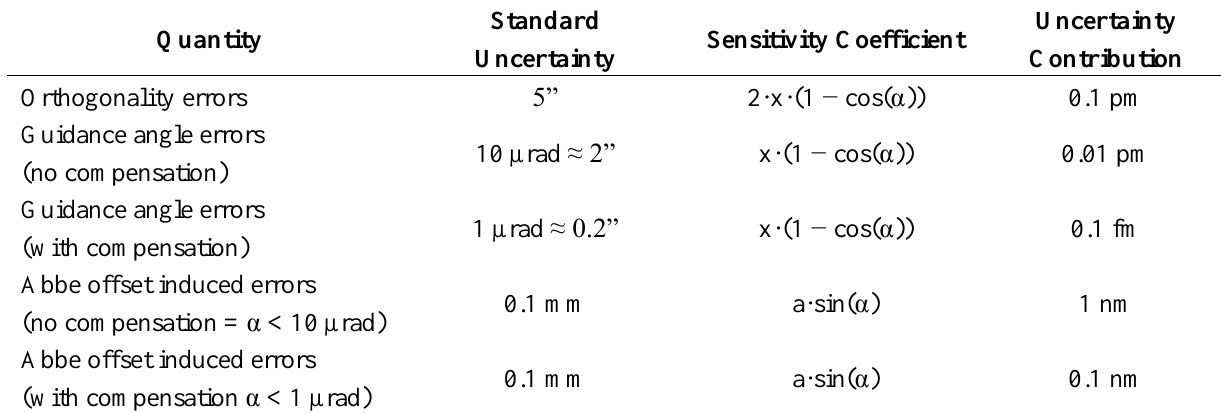
Table 1. Uncertainty estimates for the positioning and displacement measuring system